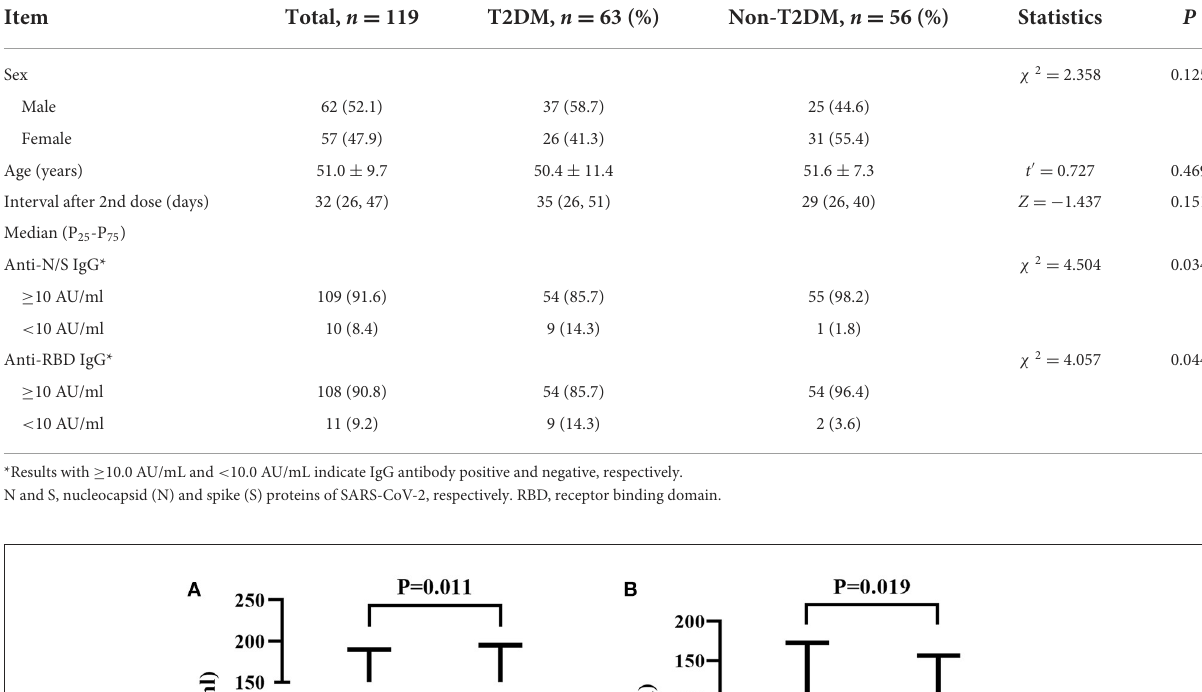
IgG in the T2DM patients with fasting blood glucose ≥ 7 mMol/L were both 75.0% (95% CI 55.1, 89.3%), significantly lower than the rates (94.3% [95% CI 80.8, 99.3%]) in the patients with fasting blood glucose < 7 mMol/L ( P = 0.030), and lower than those (anti-N/S IgG 98.2% and anti-RBD IgG 96.4%) in the non-T2DM individuals ( P = 0.003 and 0.009, respectively). However, compared to non-diabetic controls, T2DM patients with fasting blood glucose < 7 mMol/L had similar positive rate for anti-N/S IgG (94.3 vs. 98.2%, P = 0.676) and for anti-RBD IgG (94.3.0 vs. 96.4%, P = 1.000) (Figure 2A).